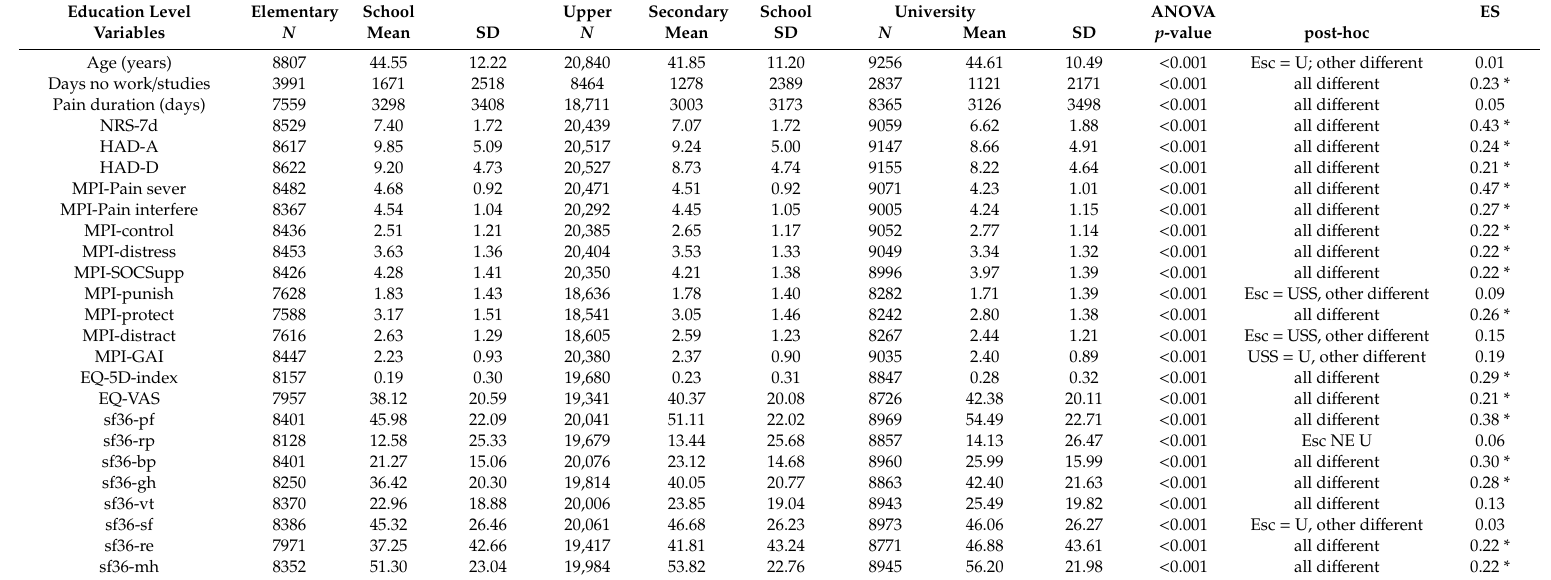
Table 3. Comparison at baseline between di ff erent levels of education. The statistics (ANOVA including post hoc tests) and e ff ect size (ES; Hedges’ g) for Elementary School vs. University are to the far